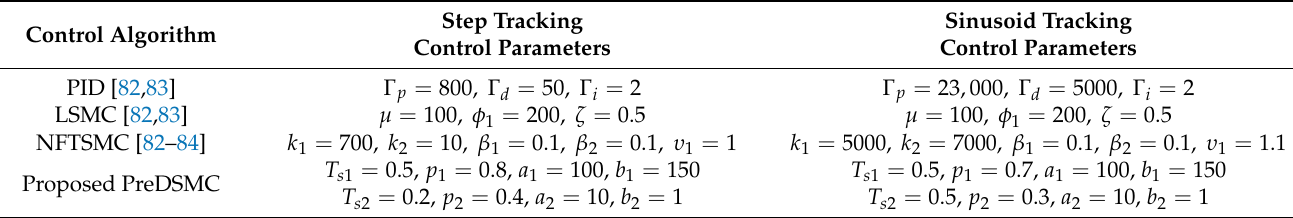
Table 2. Parameters of the